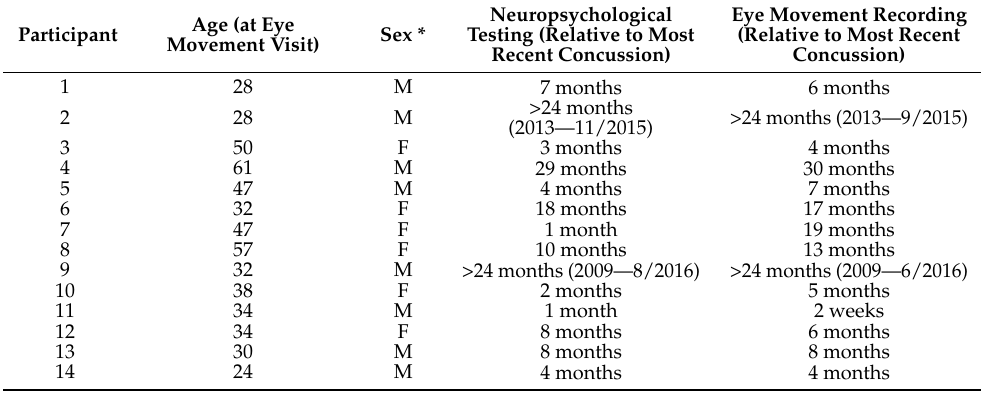
Table 1. Patient demographics and timing of assessments relative to last